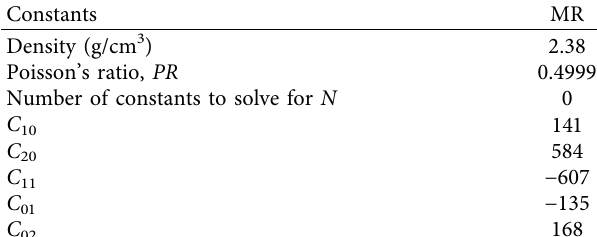
Table 4: ∗ MAT_HYPERELASTIC_RUBBER for MR.